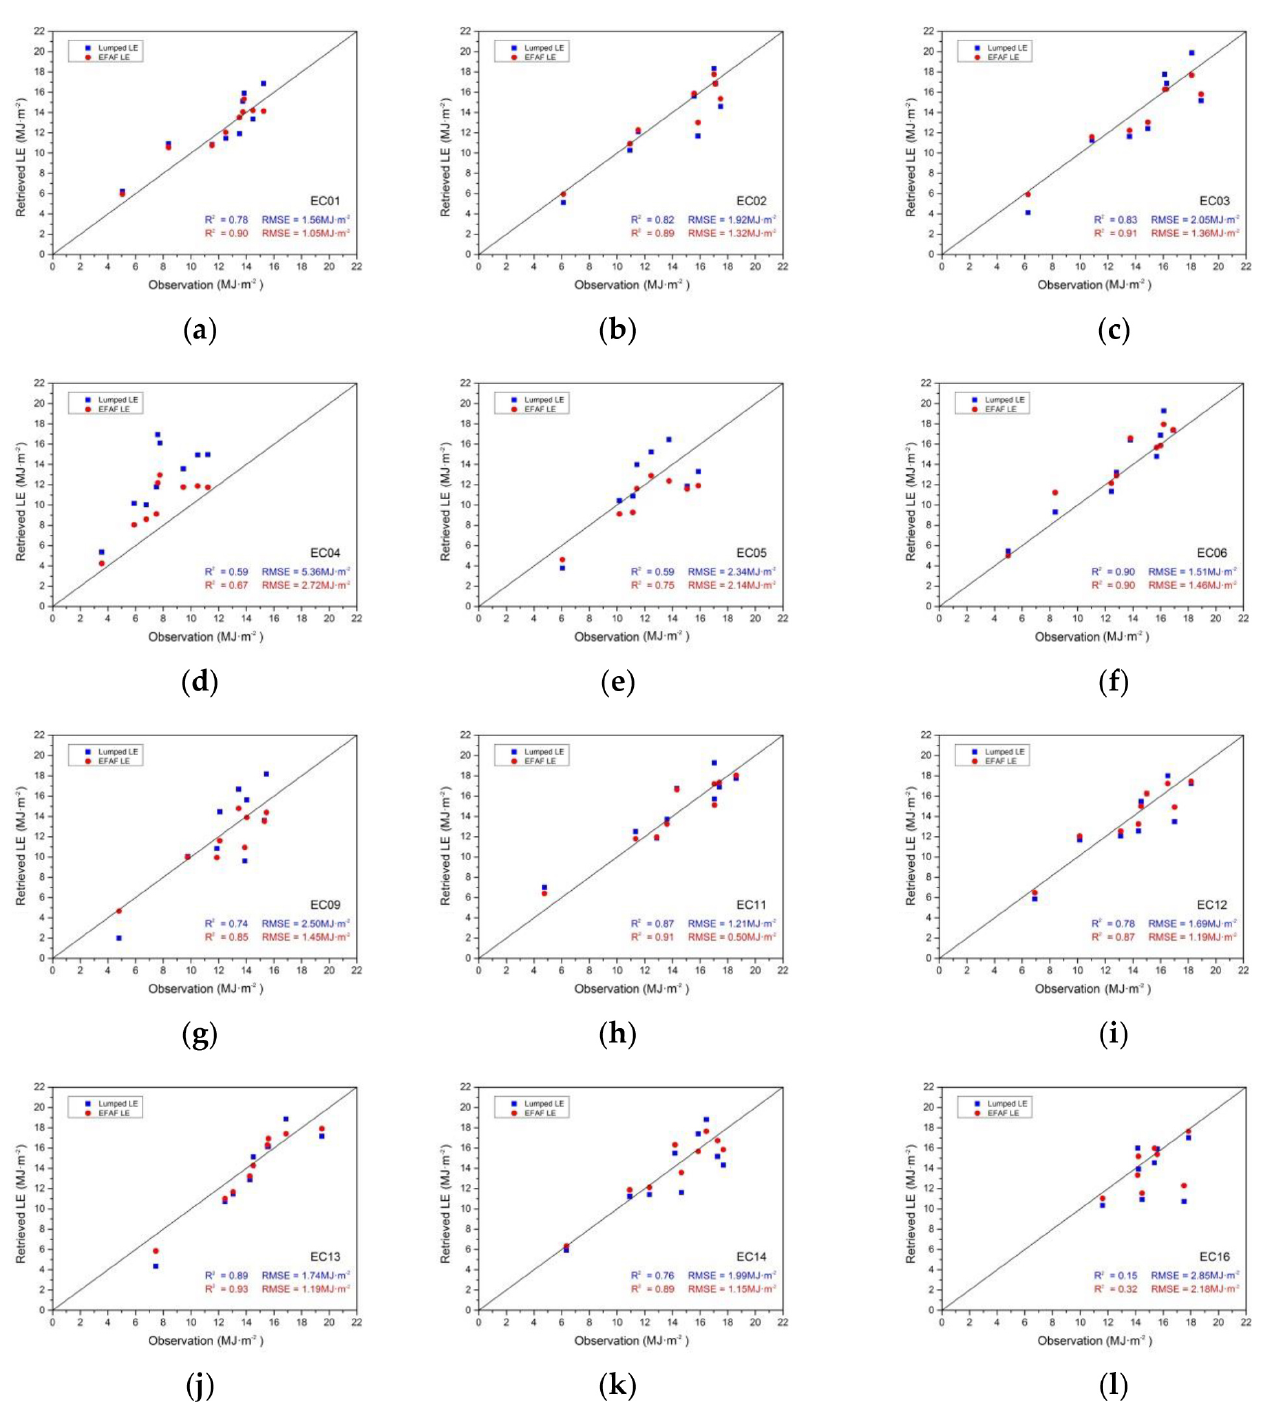
Figure 8. Scatter plots of the lumped LE (blue) and EFAF LE (red) against the EC measurement LE at each